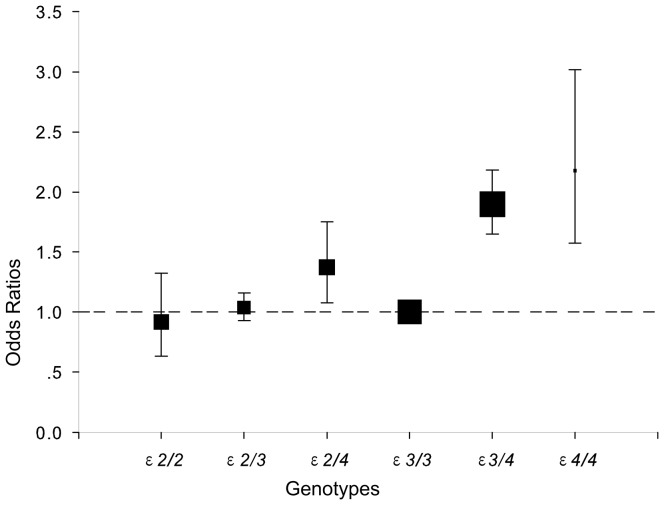
The comparison of ORs between ε3/3 and all the other genotypes for coronary heart disease, based on 61 studies.Size of data symbols is proportional to the inverse of the variance of odds ratios (ε3/3 is displayed with forced fixed size) and error bars represent 95% confidence intervals (CIs).